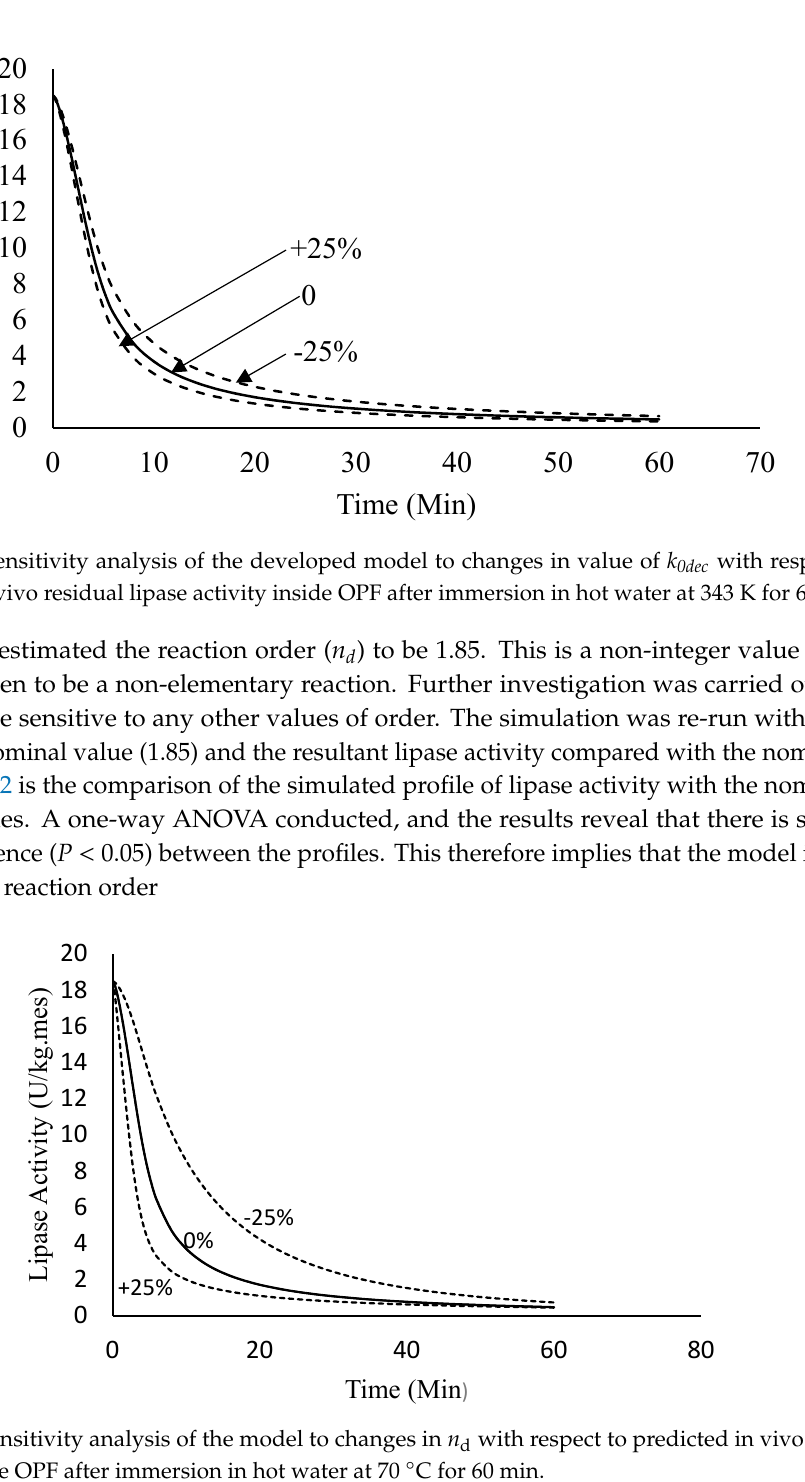
Figure 12. Sensitivity analysis of the model to changes in n d with respect to predicted in vivo lipase activity inside OPF after immersion in hot water at 70 °C for 60 min.